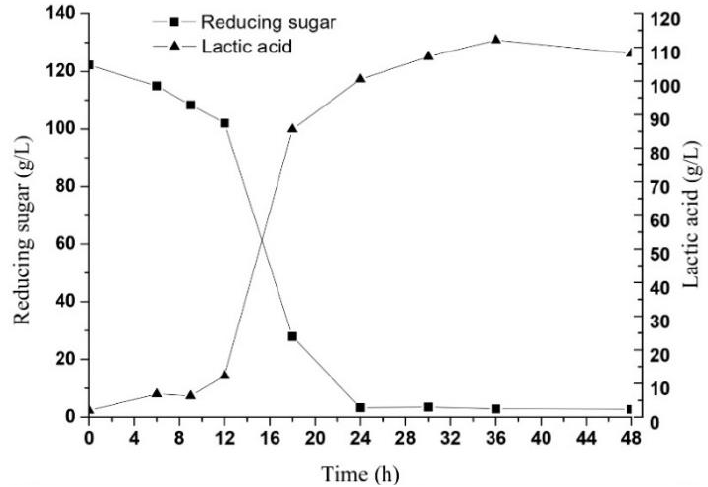
Figure 4. Kinetics of lactic acid production and sucrose consumption in shake flask fermentation at 150 rpm and 35 °C.